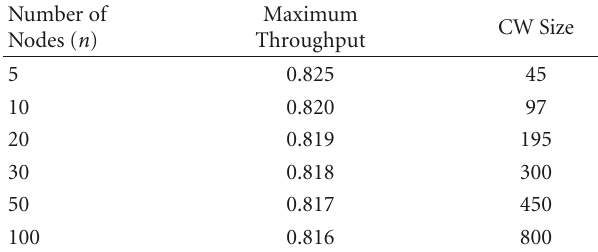
Figure 4: Relation between average access delay and contention window. Table 3: Number of nodes versus maximum throughput.